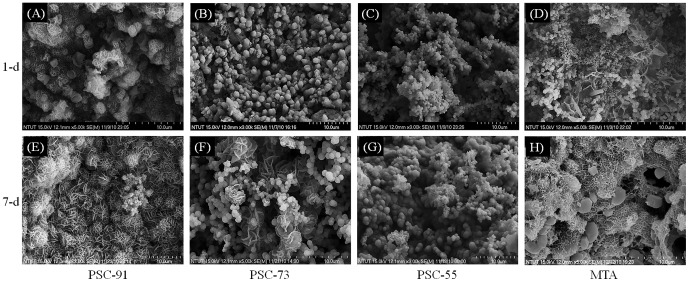
SEM micrograph of the surface of specimens stored in simulated body fluid (SBF) various durations.Soaked in SBF after 1 day: (A) PSC-91 (B) PSC-73 (C) PSC-55 (D) MTA; Soaked in SBF for 7 days: (E) PSC-91 (F) PSC-73 (G) PSC-55 (H) MTA